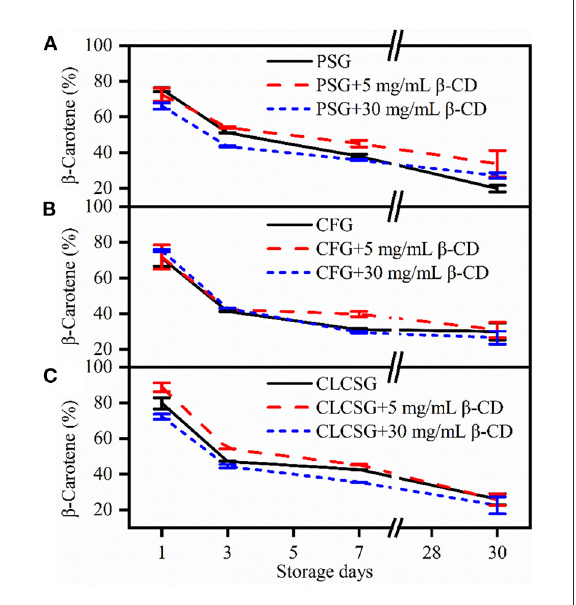
FIGURE4 Stability of β -carotene in fish oil-loaded emulsions stabilized by gelatins ( A : PSG; B : CFG; C : CLCSG) with β -CD at 4 ◦ C.